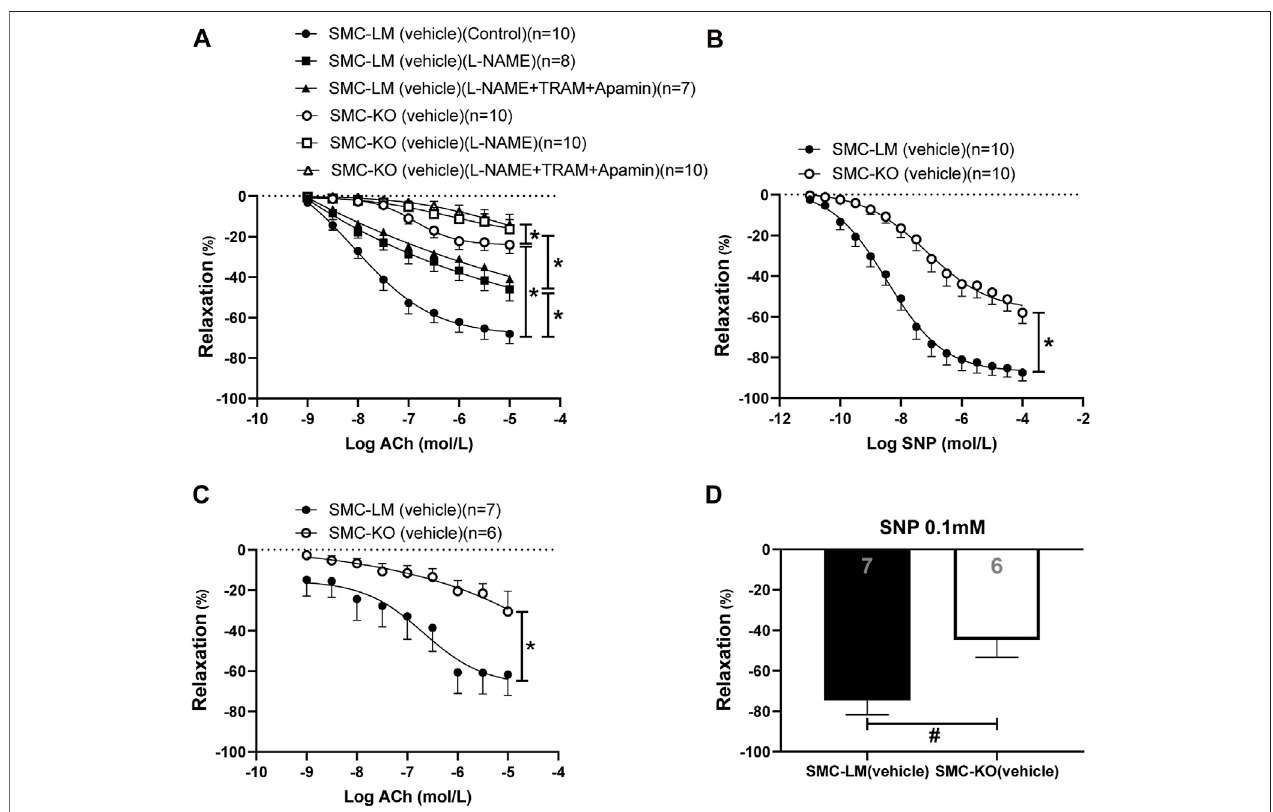
FIGURE 1 | Endothelium-dependent and – independent responses and the contribution of NO and EDH pathways in isolated aortic rings (A,B) and the endothelium-dependent and – independent responses in mesenteric (C,D) rings from SMC-KO mice (open circles, bar) versus rings from SMC-LM ( fi lled circles, bar) measured ex vivo in small wire organ baths. Relaxations are calculated relative to the contraction produced by U46619 30 mmol/L in each ring, which are set at 100%. Values are expressed as means ± SEM; n, number of mice; *, p < 0.05, GLM for repeated measures. #, p < 0.05, two-sided t -test.